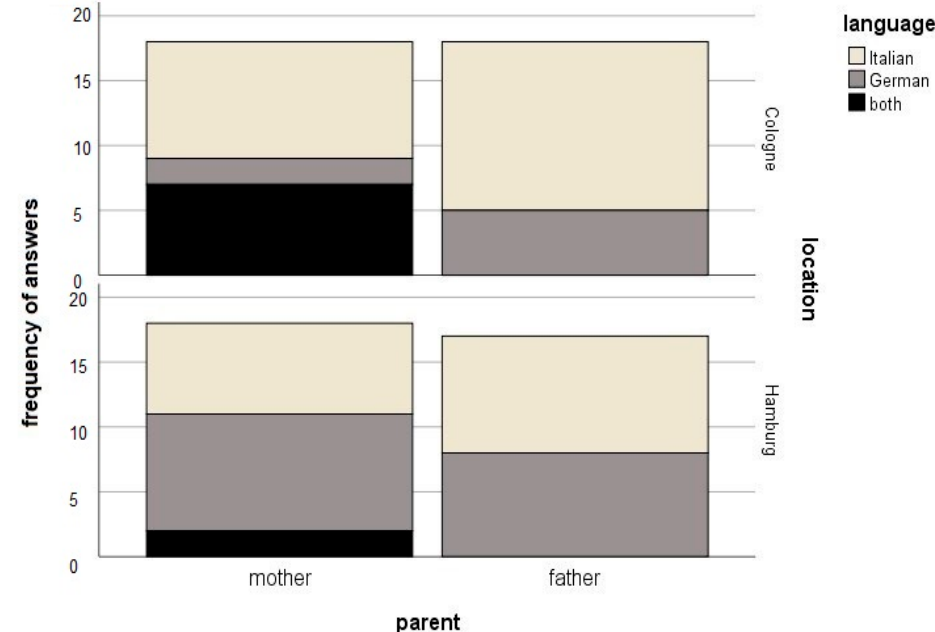
Figure 1. Frequency of occurrence of the answers “German,” “Italian,” and “both” to the question and the fathers Which language do you think you speak better? The figure considers the answers given by the mothers and the fathers individually.